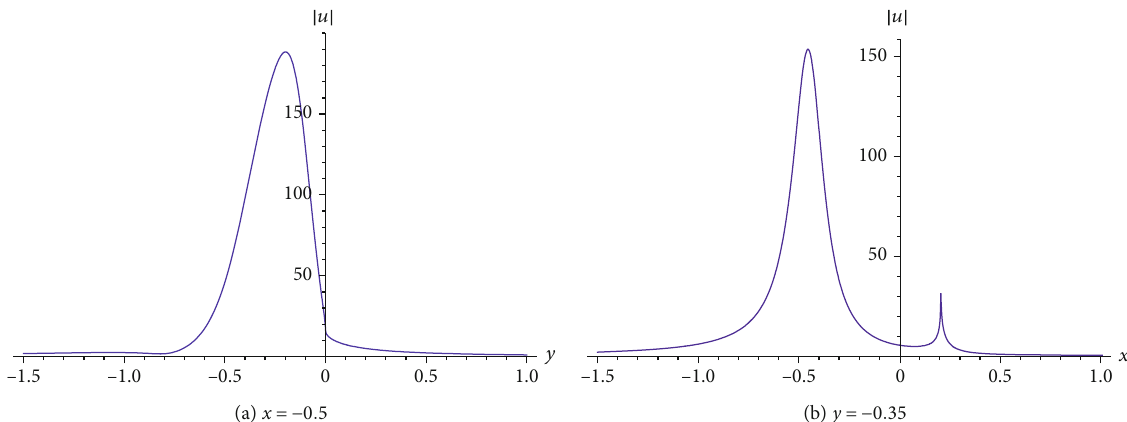
= − 0 : 6 , a = 0 : 8 , and t = 0 2 6